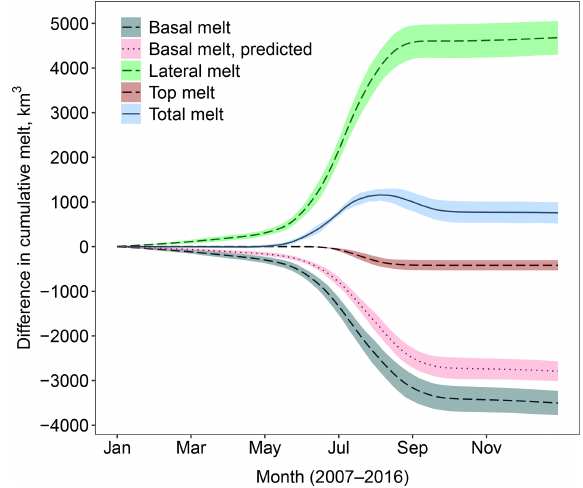
Figure 7. As Fig. 4 but the difference between (A) compared to stan-fsd i.e. the impact of changing α from 2.5 to 3.5 with the other FSD parameters held at standard values. A large increase in lateral melt is partly compensated by a reduction in basal melt; however this time a large increase is seen in the total